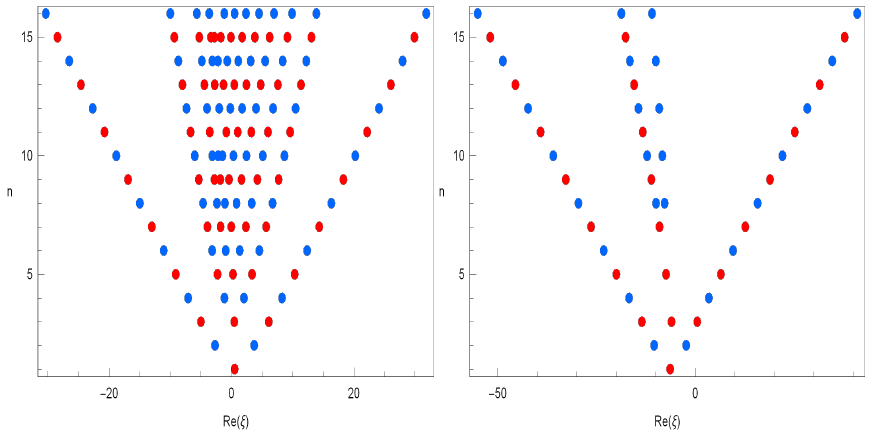
Figure 4. Stacks of zeros of Bel H